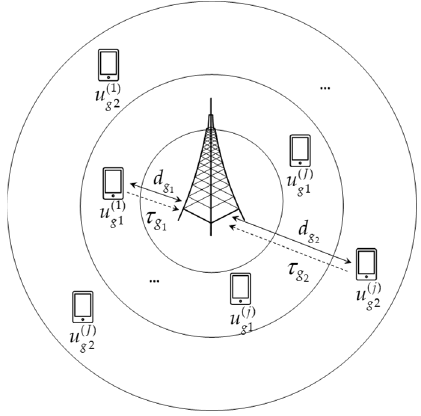
Figure 2. Multi-user grouped model. Figure 2. Multi‑user grouped